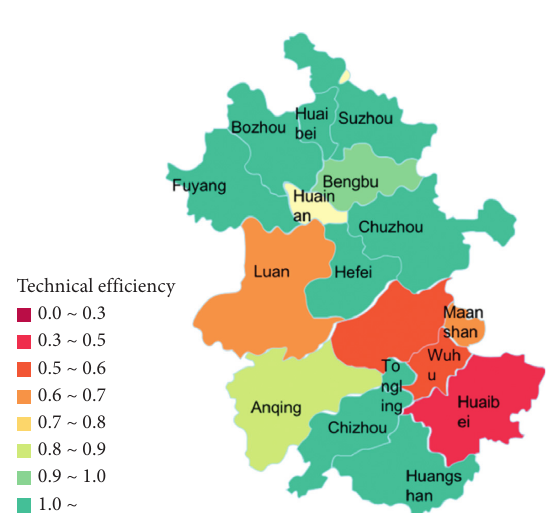
Figure 7: Technical efficiency